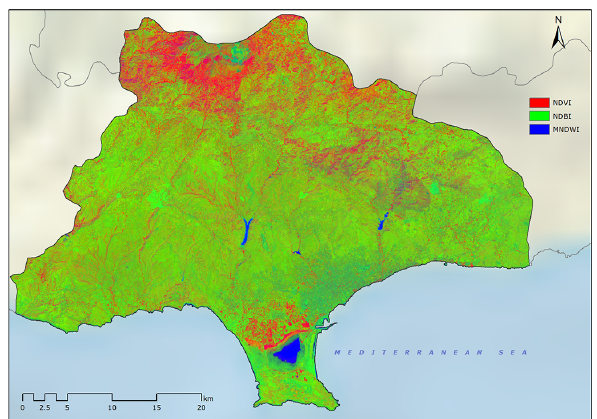
Figure 3. Results from Landsat 8 OLI/TIRS image classification in NDVI, NDBI, and